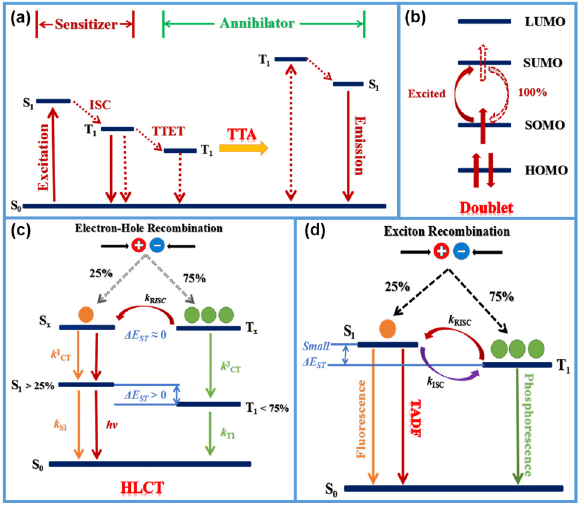
Figure 1. Brief mechanisms for ( a ) TTA, ( b ) doublet, ( c ) HLCT, ( d ) fluorescence, phosphorescence, and TADF.